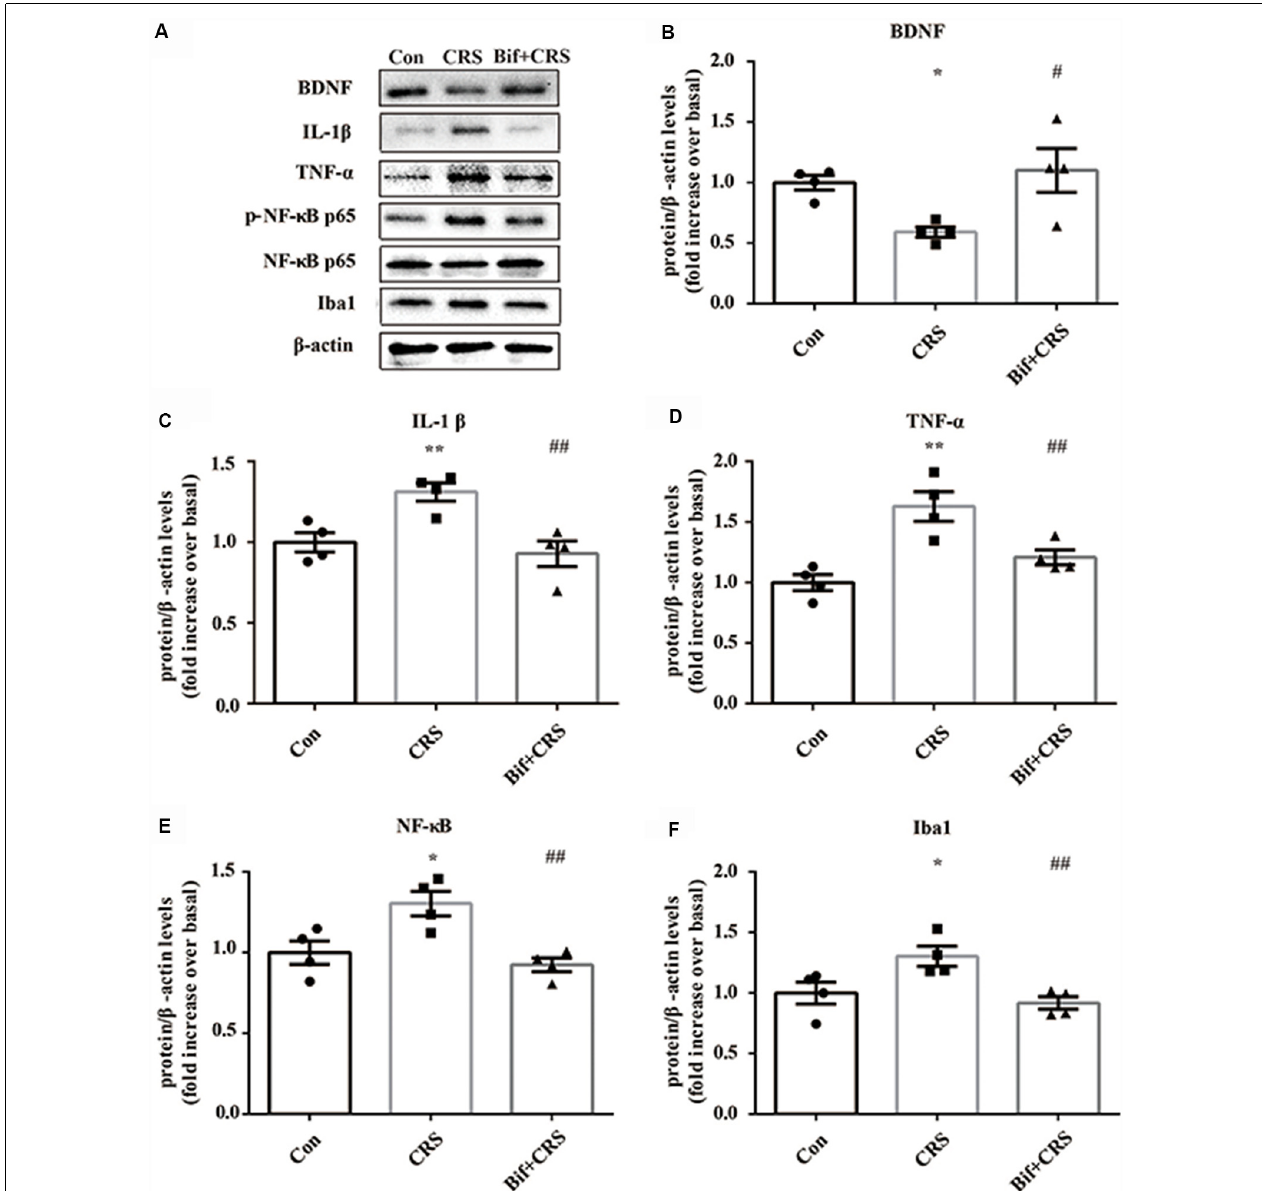
FIGURE 5 | Changes in the protein expression of BDNF, IL-1 β , TNF- α , p-NF- κ B p65 and Iba1 in the hippocampus induced by pretreatment with B. adolescentis . The mice in the Con, CRS, and Bif+CRS groups were treated with 10 mL/kg distilled water, 10 mL/kg distilled water, and 0.25 × 10 9 CFU/kg B. adolescentis , respectively, by gavage for 21 days. (A) Western blotting showed that (B) the protein level of BDNF was upregulated by B. adolescentis , and the protein levels of (C) IL-1 β , (D) TNF- α , (E) p-NF- κ B p65 and (F) Iba1 in the hippocampus were obviously suppressed by B. adolescentis . The data are shown as the mean ± SEM. One-way ANOVA followed by the Student-Newman-Keuls test was used. ∗ p < 0.05 and ∗∗ p < 0.01 vs. the control; # p < 0.05 and ## p < 0.01 vs. the CRS group; n = 4 per group. Con, Control; CRS, chronic restraint stress; Bif+CRS, B. adolescentis + chronic restraint stress; BDNF, brain derived neurotrophic factor; IL-1 β